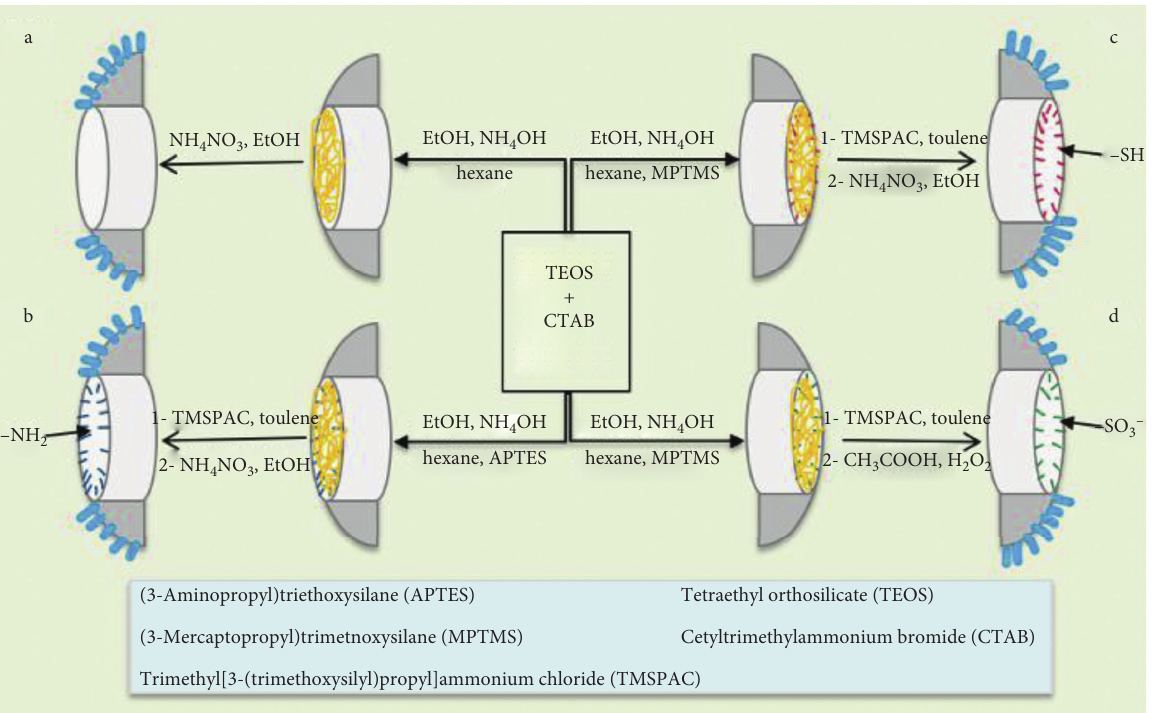
Scheme 1: Illustration of surface modification process of mesoporous silica nanoparticles (MSNs). (a) Outer surface of MSNs modified with trimethyl[propyl]ammonium chloride group (TMPAC-MSNs), (b) external surface of MSNs-NH 2 functionalized with